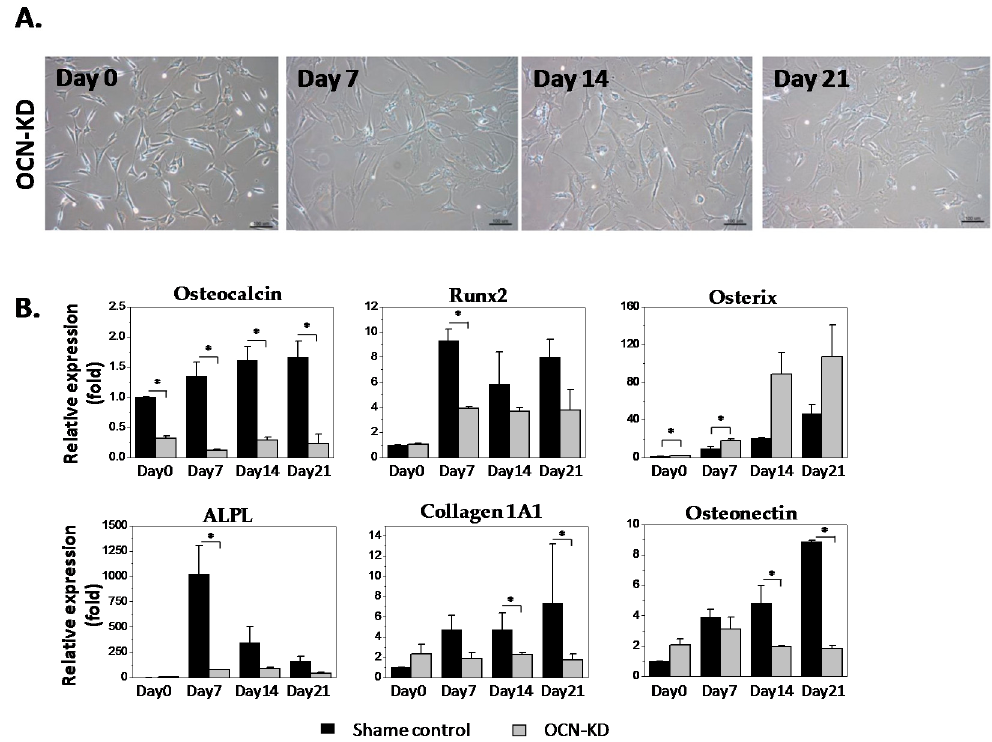
Figure 2. ( A ) Photomicrograph of osteocalcin-knockdown (OCN-KD) cultured on quartz coverslips in osteogenic induction medium at day 0, 7, 14, and 21. Scale bar: 100 μ m. The halo regions surrounding cell edges of MSCs are the artifacts due to phase contrast microscope; ( B ) the gene expression of Sham and OCN-KD groups. Data are shown as mean ± SD ( n = 3). Student’s t -test was used for two group analysis with significant difference indicated by asterisks (* p < 0.05).